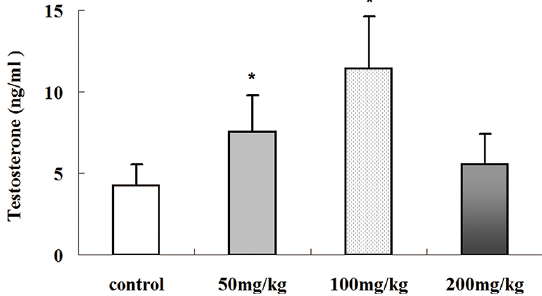
Figure 5. Effects of icariin on serum testosterone levels in male SD rats. Serum testosterone concentrations were evaluated individually in all groups of rats by ELISA. Values are the mean ± SD of 10 rats. * p < 0.01 vs. control